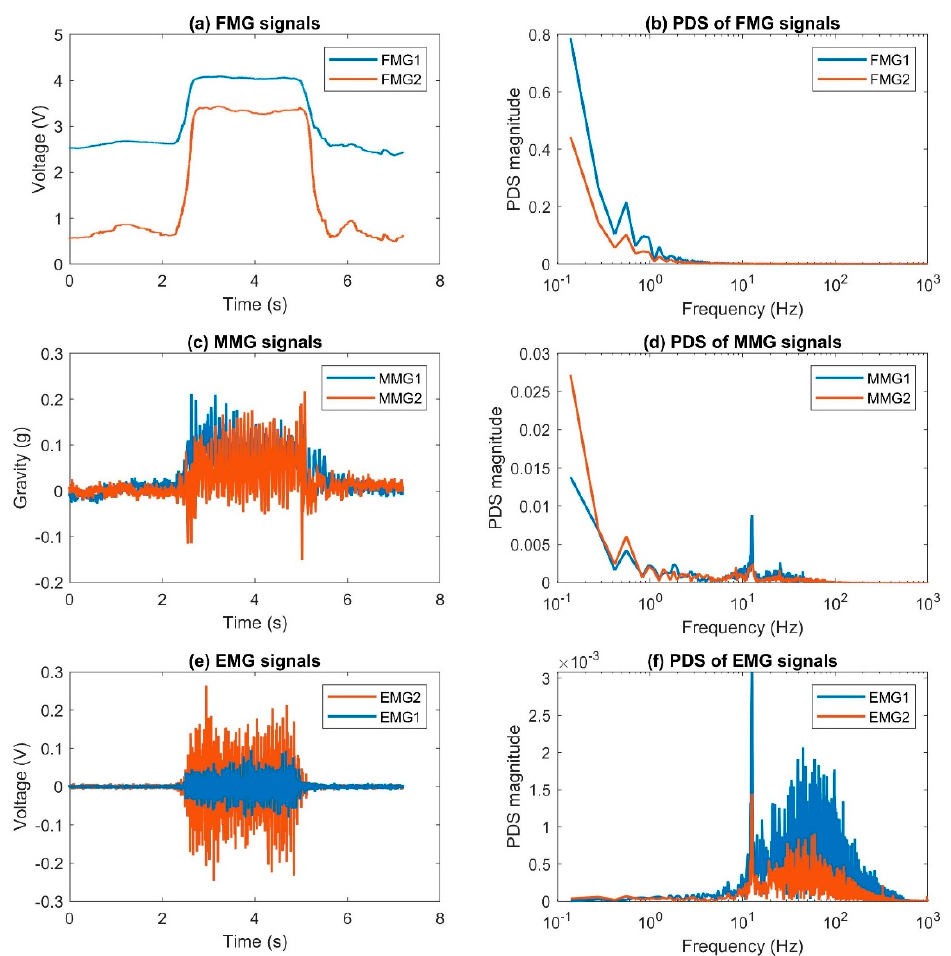
Figure 9. An example of FMG, MMG, and sEMG during a squeezing action ( a , c , e ). The blue lines show the signals that were captured from Sensor 1, the orange lines show the signals that were captured from Sensor 2. The x-axes of plot ( b , d , f ) are using the log scale.